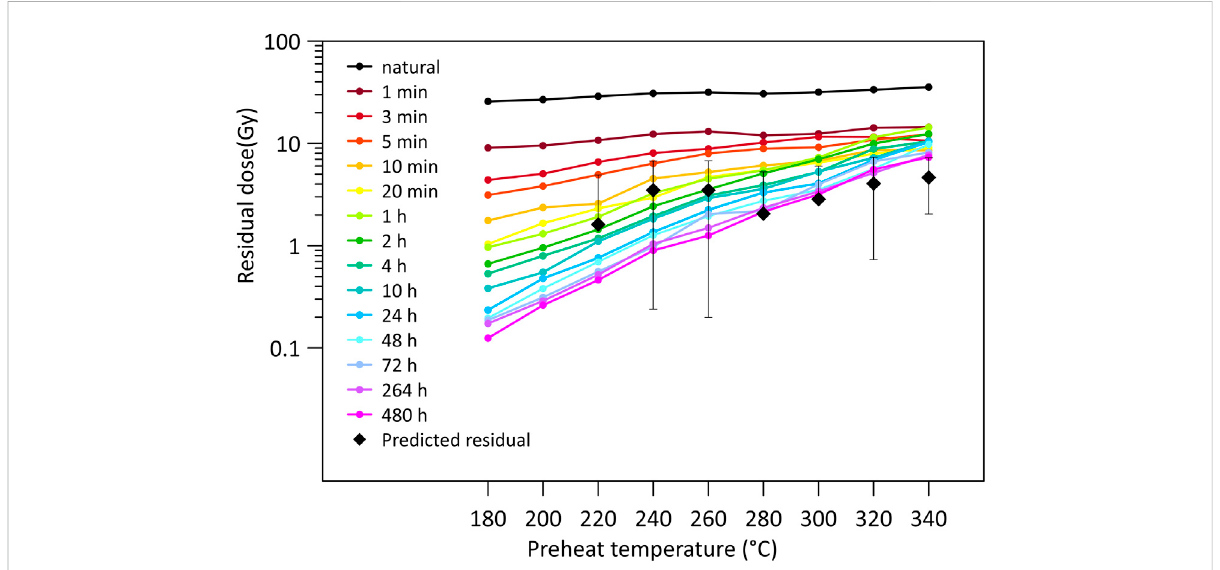
FIGURE 5 Predicted residual doses (solid diamonds; cf. Figure 4) superimposed onto the calculated residual doses from the laboratory bleaching experiments. The calculated residual doses refer to the remaining doses after different exposure times in SOL2. The uncertainties of the predicted residual doses were larger than the values themselves at preheat of 220, 280 and 300 ° C, so that the error bars on the negative direction cannot display on the log scale.